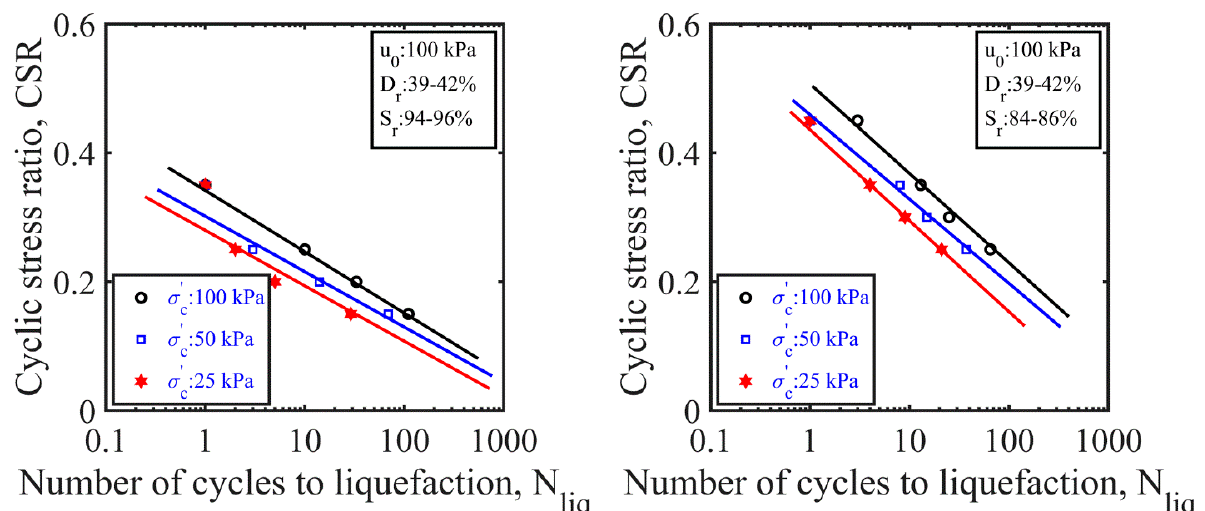
Figure 8. Effect of confining stress on liquefaction resistance of partially saturated sand specimens.